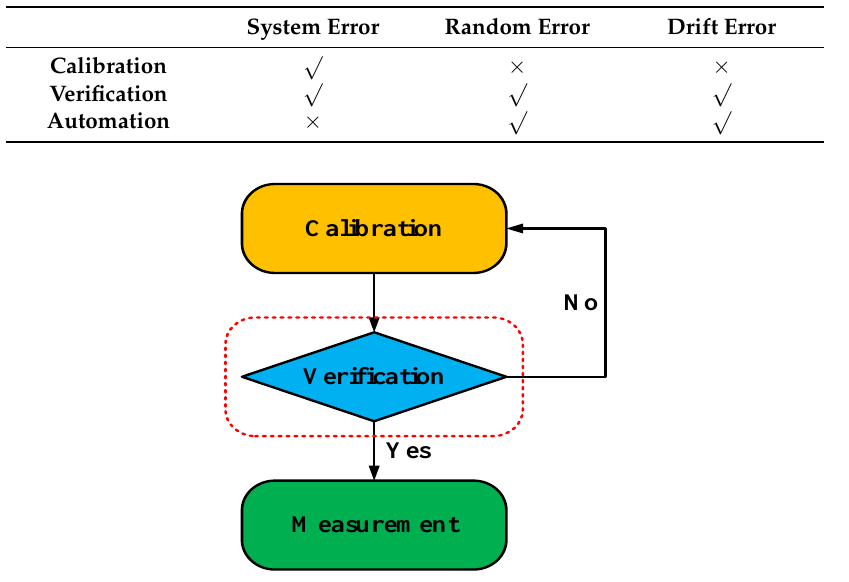
Figure 2. Test process generalizations.